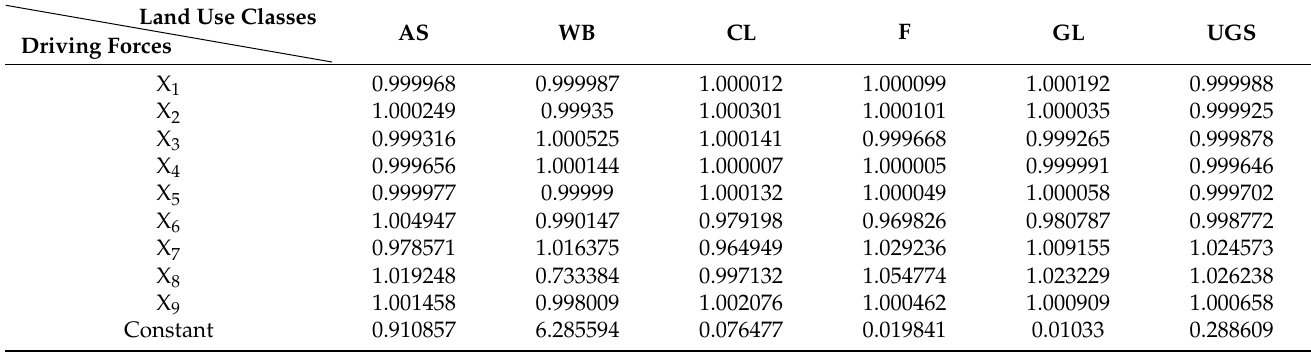
Table 2. Odd ratio for each driving forces for different land use